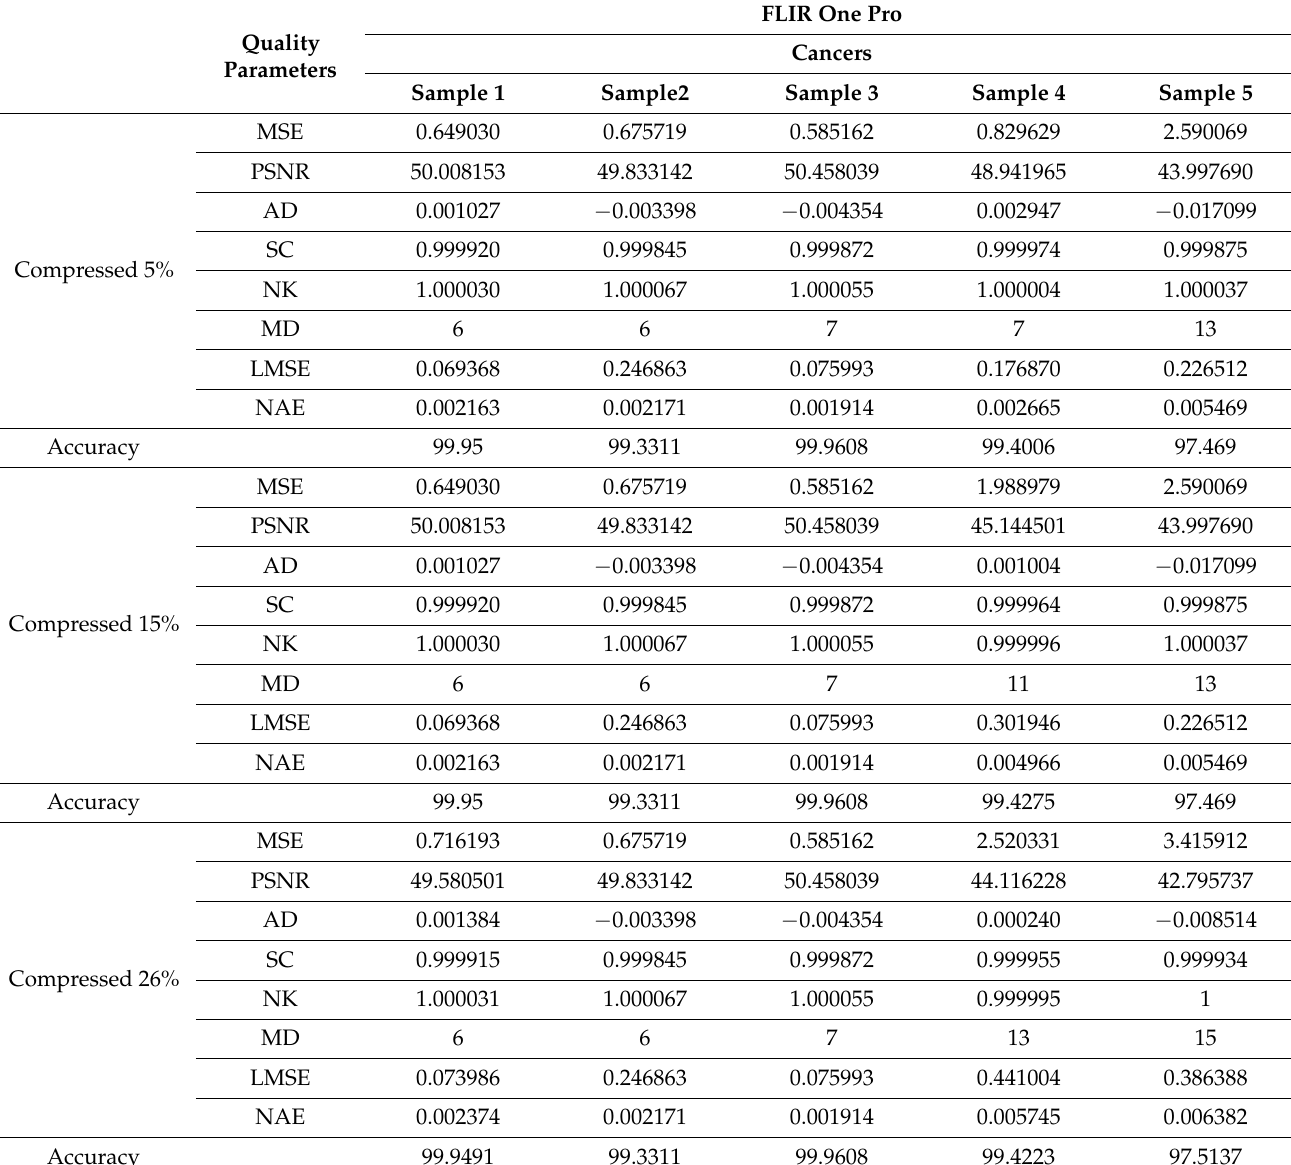
Table 5. Compressed FLIR one pro image and check quality.